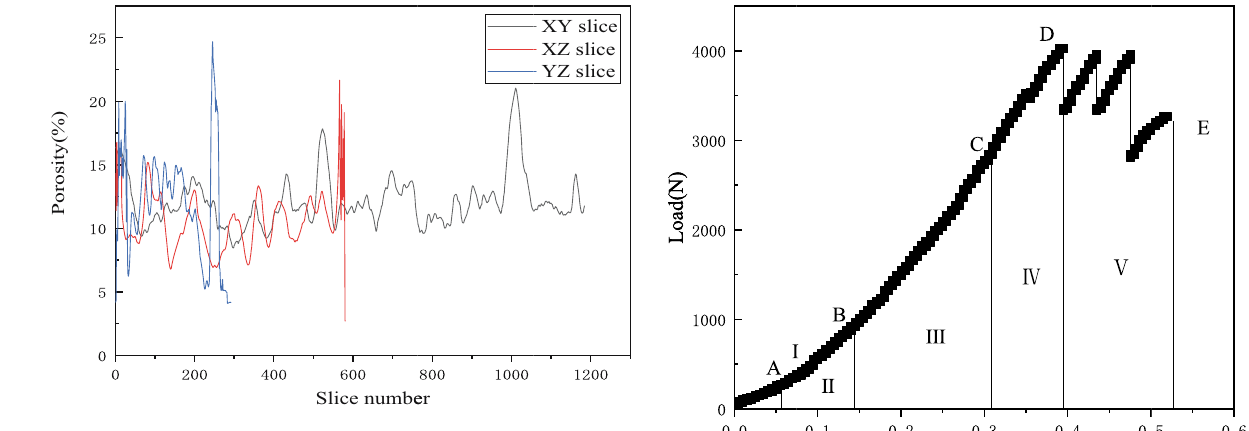
Figure 4: Porosity distribution of slices in three di ff erent directions.